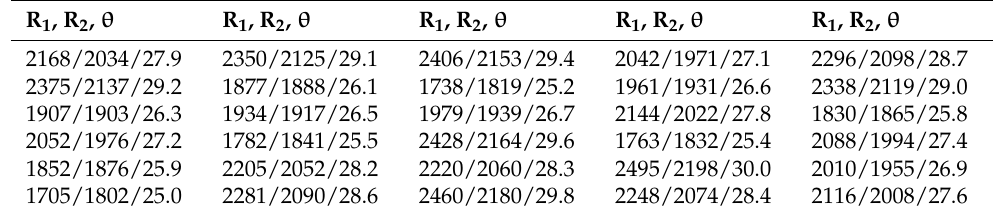
Table 6. Chute structure parameter combinations.